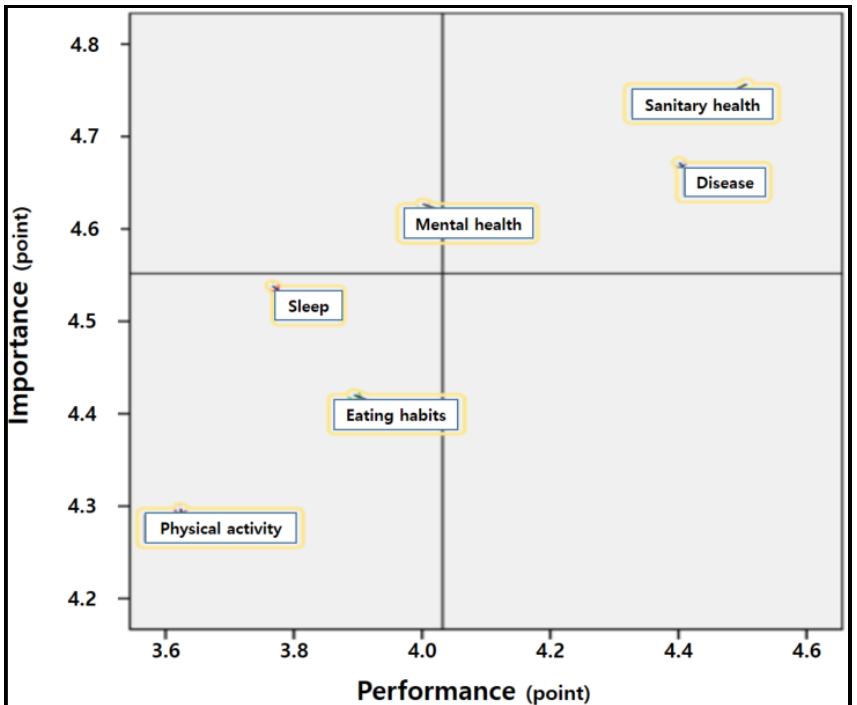
Figure 1. Importance-performance analysis matrix. Table 7. Distribution of dimensions of health perception.